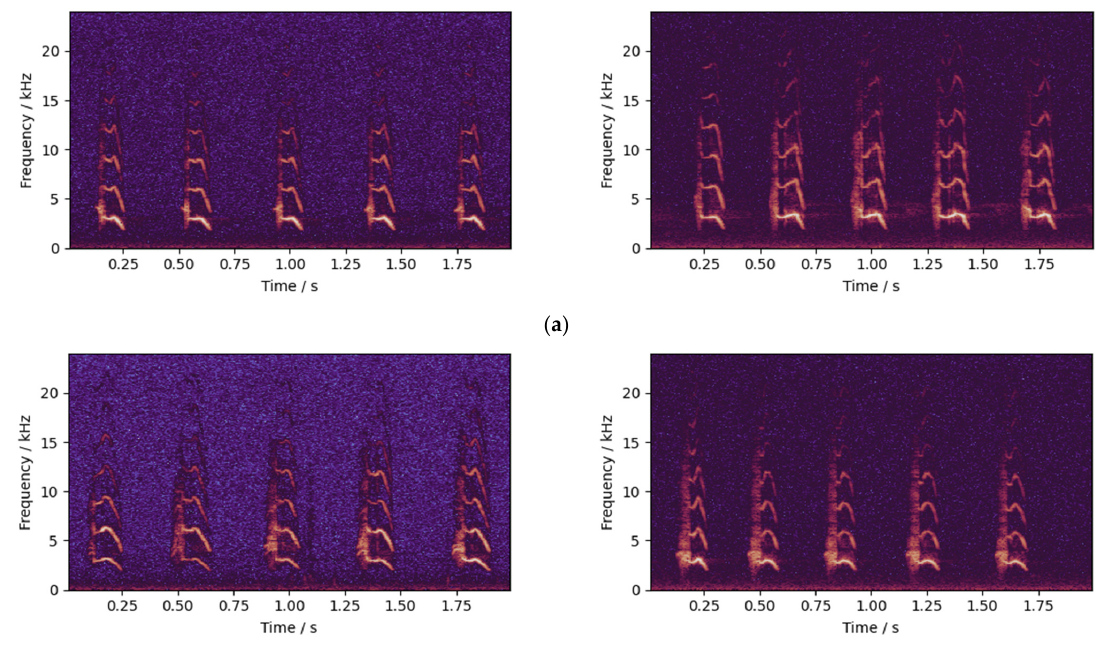
Figure 3. Normalized spectrogram of calls of 2 cocks and 2 hens: ( a ) cocks; and ( b ) hens.